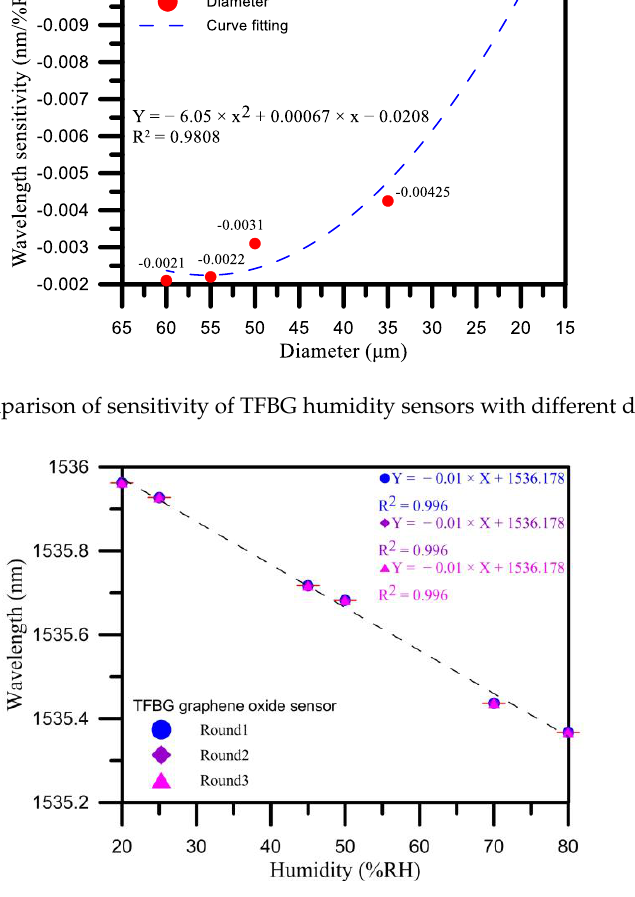
Figure 10. 3-cycle repeat test TFBG humidity wavelength results.